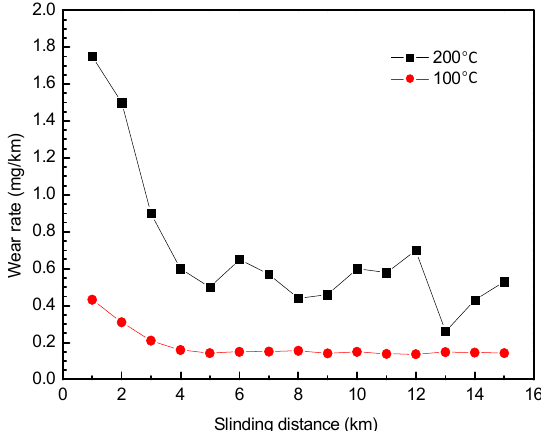
Figure 6. The wear rate of GFRPTFE versus sliding distance of the friction pair at 100 °C and 200 °C.